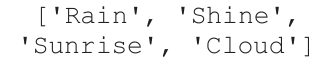
Fig. 2. Exploratory data analysis